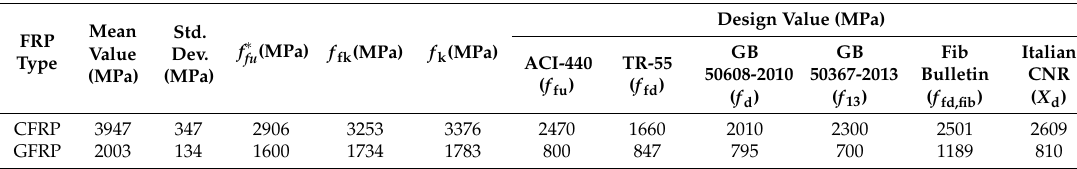
Table 4. Design values of tensile strength of FRP materials.